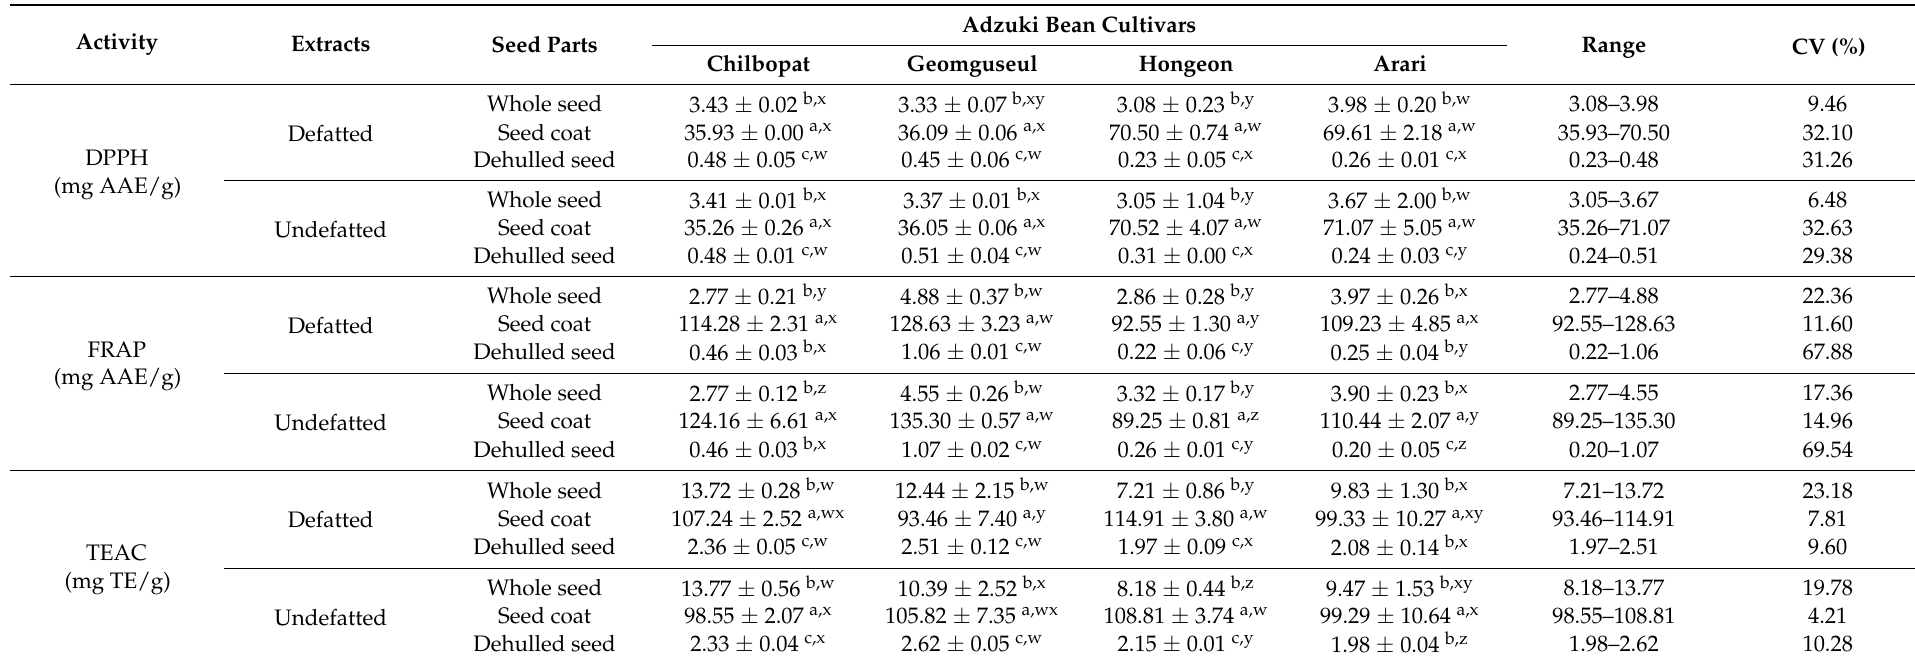
Table 3. Antioxidant activities of the whole seeds, seed coats, and dehulled seeds of four Korean adzuki bean